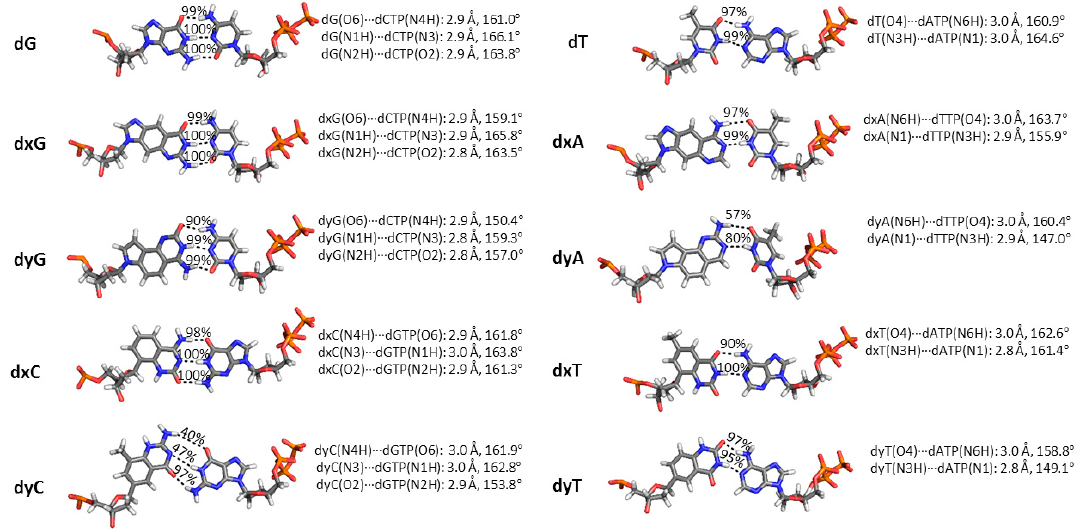
Figure 4. Geometry of the dN:dNTP hydrogen-bonding interaction during Dpo4 replication of a DNA, xDNA or yDNA base. Average distance and angle for each hydrogen-bonding interaction are given, as well as hydrogen-bonding occupancies, which are based on a distance cutoff of <3.4 Å and an angle cutoff of >120°.